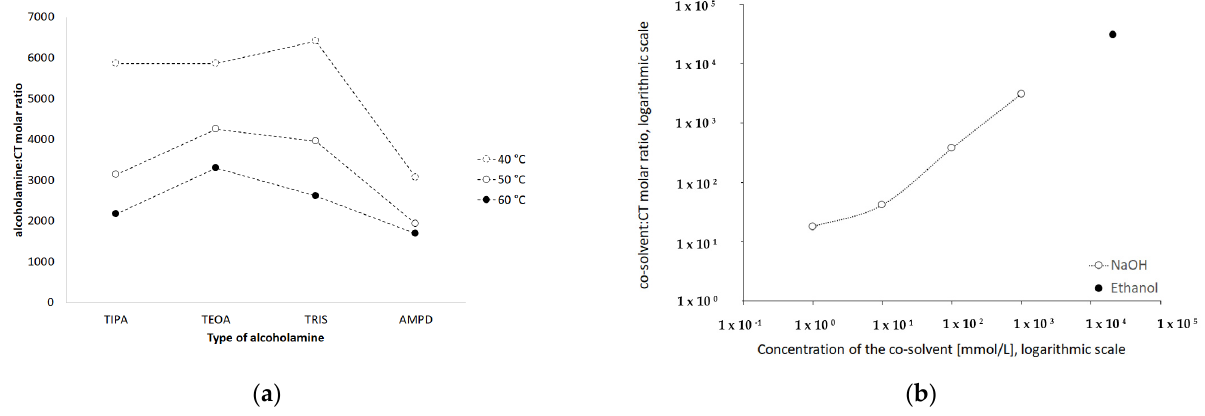
Figure 11. Influence of type of the alcoholamine on the molar ratio alcoholamine/CT in solutions prepared in varied temperature ( a ) and the influence of increasing concentrations of NaOH and of 96% ethanol on the molar ratio cosolvent/CT ( b ).